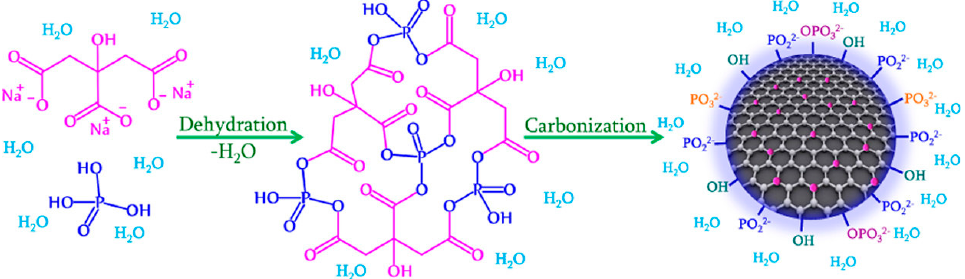
Figure 8. Schematic representation of the synthesis of P-doped CQDs from trisodium citrate and phosphoric acid. Reprinted from ACS Omega , 5, G. Kalaiyarasan, J. Joseph, and P. Kumar, Phos- phorus-Doped Carbon Quantum Dots as Fluorometric Probes for Iron Detection , pages 22278–22288,